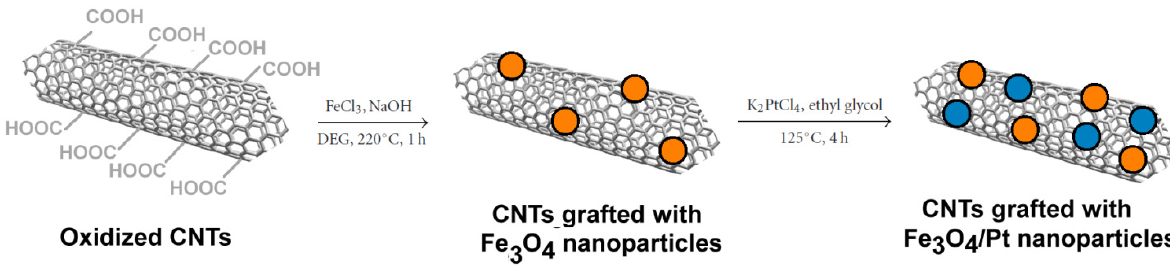
Figure 9. Fe O /Pt nanoparticles loaded on carbon nanotubes (CNTs) by a high-temperature 3 4 solution-phase hydrolysis